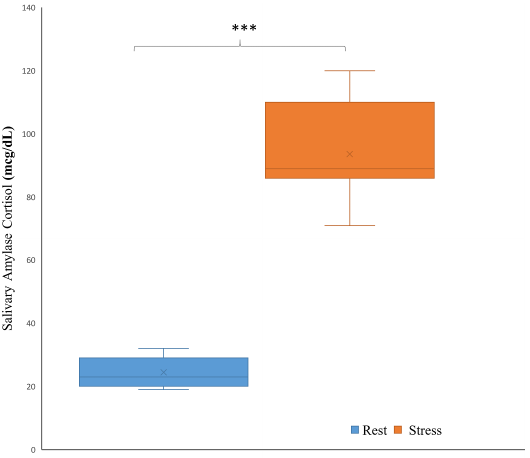
Figure 4. The mean and standard deviation of the salivary amylase cortisol measured by (mcg/dL) for rest and stress